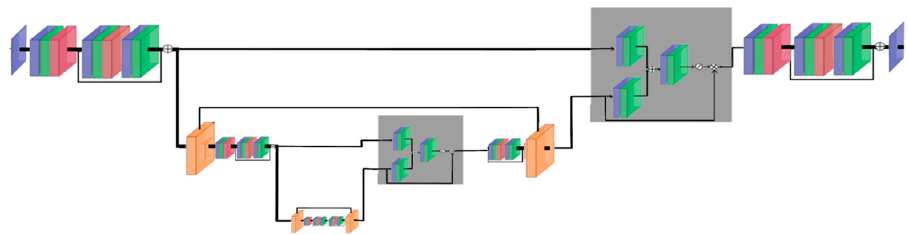
Figure 3. The neural network architecture for OLCI images; blue layers are convolutions, green ones represent batch normalizations, ReLU is in red, and yellow layers correspond to max pooling/un- pooling layers. Gray blocks represent soft attention.